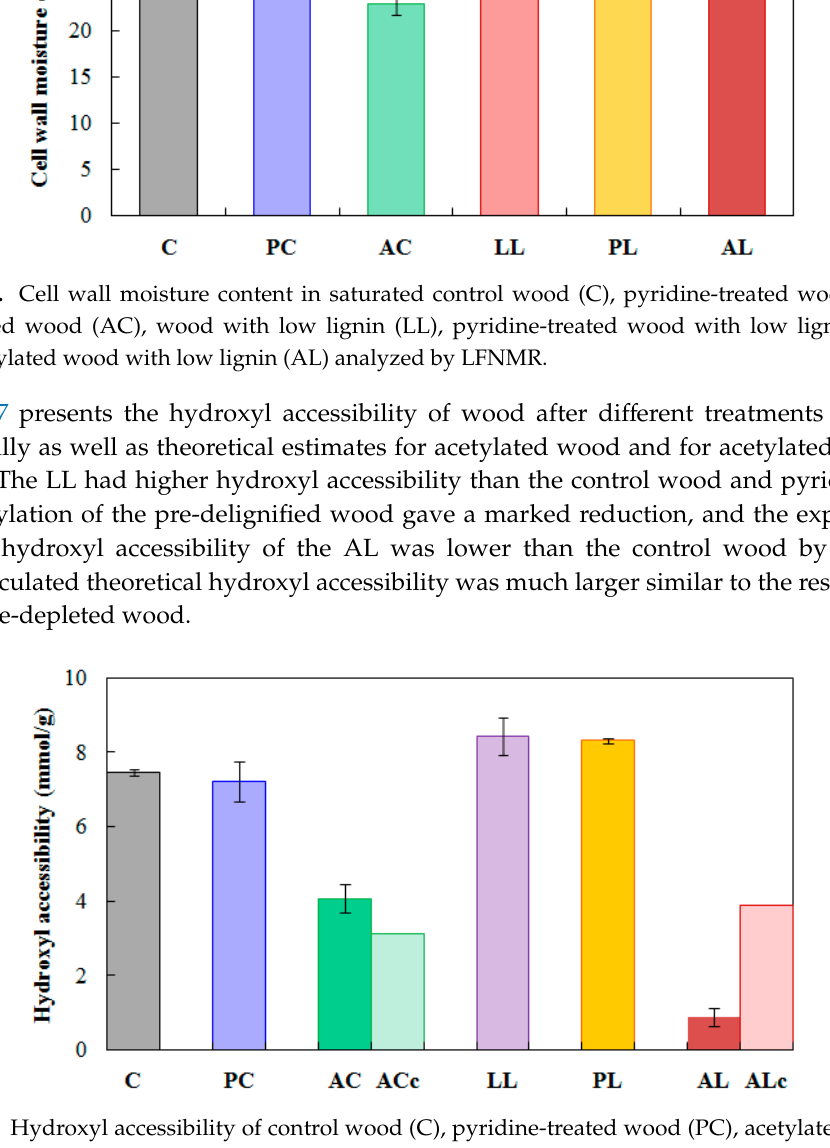
8 of 13 Figure 5. Continuous T 2 (spin–spin) distributions for control wood (C), wood with low lignin (LL), pyridine-treated wood (PC), acetylated wood (AC), and acetylated wood with low lignin (AL). Gray filled areas represent mean values including standard deviation. The corresponding cell wall moisture content of saturated wood after different treatments is